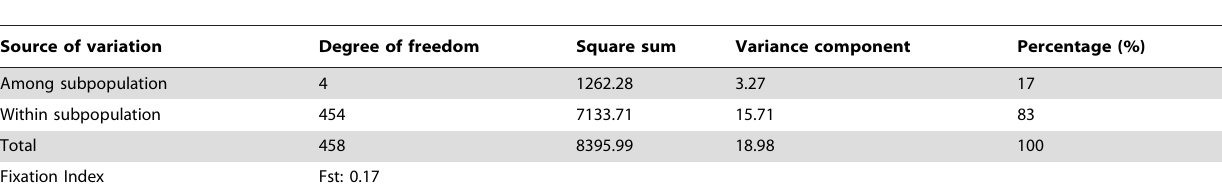
Table 2. AMOVA analysis of genetic variation between M. sinensis subpopulations. Source of variation